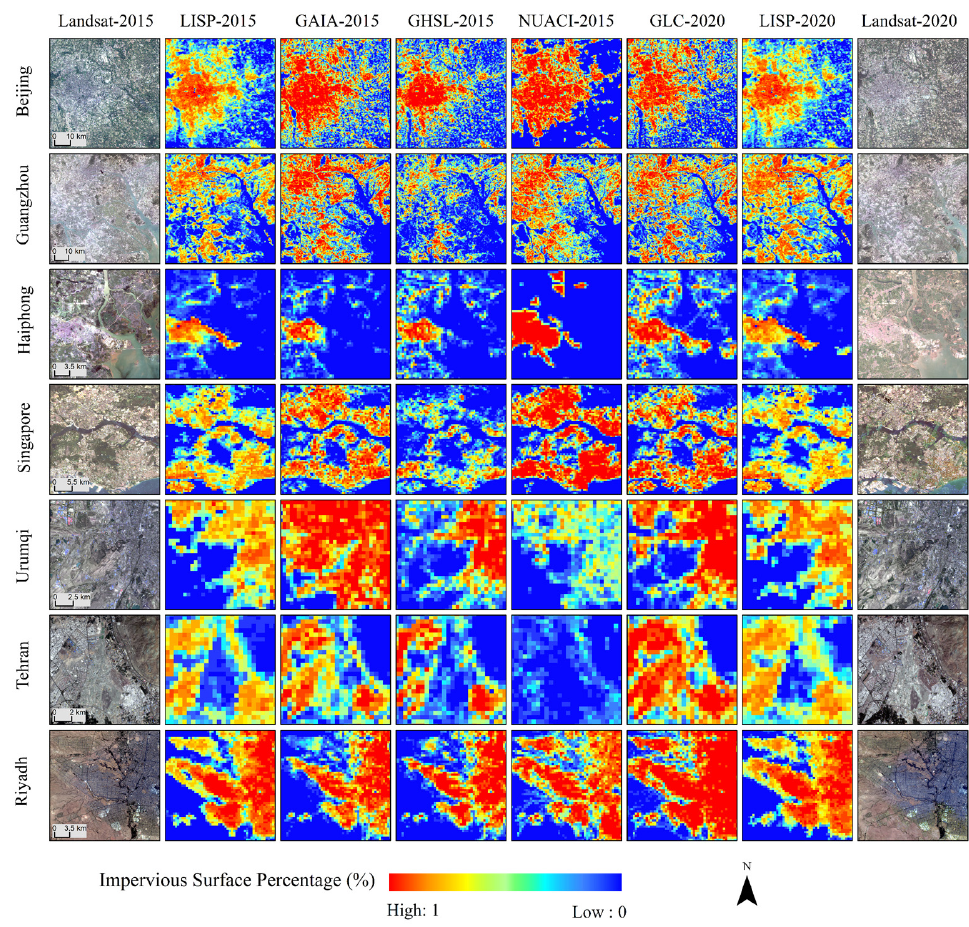
Figure 11. Comparison of different products in typical